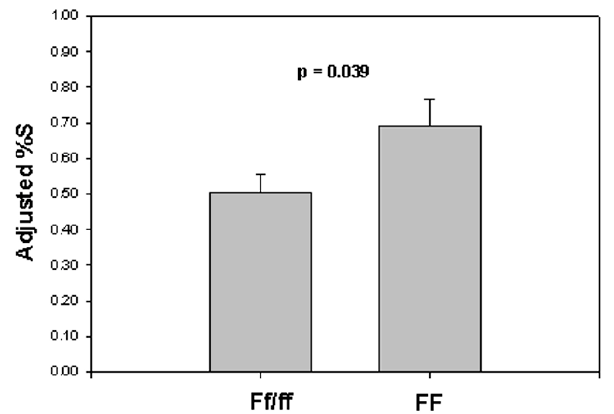
Figure 2 Adjusted insulin sensitivity (%S) by the Fok I poly- morphism at the vitamin D receptor gene locus. They were logarithmically transformed before analysis and expressed as geometric mean ± standard error. Insulin